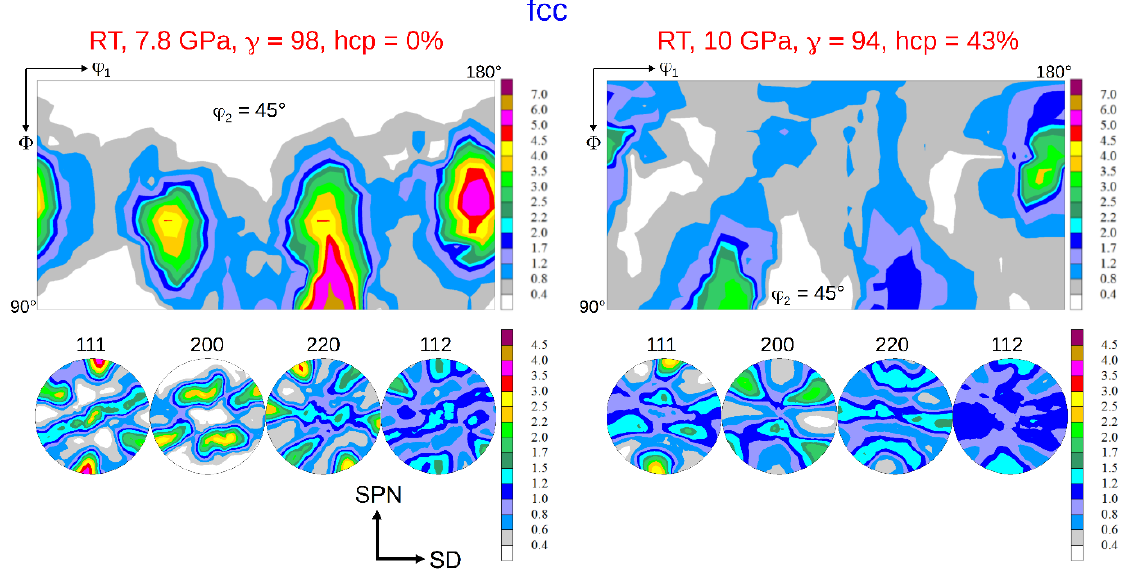
Figure 6. Texture of the fcc parent phase after HPT at RT and pressures of 7.8 GPa (no hcp phase) and 10 GPa (43 vol.% hcp phase) at a shear strain γ ≈ 100. (for key figure and designation of the fcc shear texture components see Figure 7).